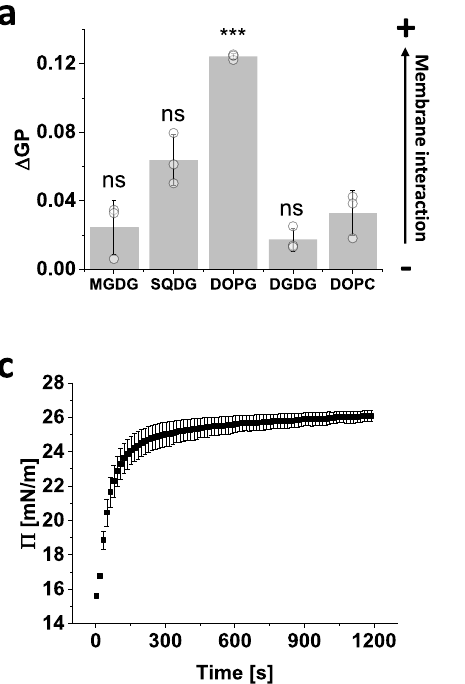
recorded after 30min and Δ GP values (black) were determined from the spectra. Mean of independent measurements ( n =4) and error bars (S.D.) are shown. Arrow indicates increasing membrane interaction. c Progression of the surface pressure (black) measured over time in parallel to the SFG intensity shown in ( d ). SFG spec- troscopy of 0.5 µ M Syn DLP was carried out on a DMPG monolayer under reaction buffer conditions (without DTT). t =0s corresponds to the moment of Syn DLP addition.Meanofthreeindependentmeasurementsanderrorbars(S.D.)areshown. d The SFG spectrum in the amide I region of the DMPG monolayer (black) and after Syn DLP addition and equilibration (red) is shown. A fi t of the amide I band is dis- played as a line. The mean of three independent measurements is shown. SFG intensity was normalized (0 – 1) for better